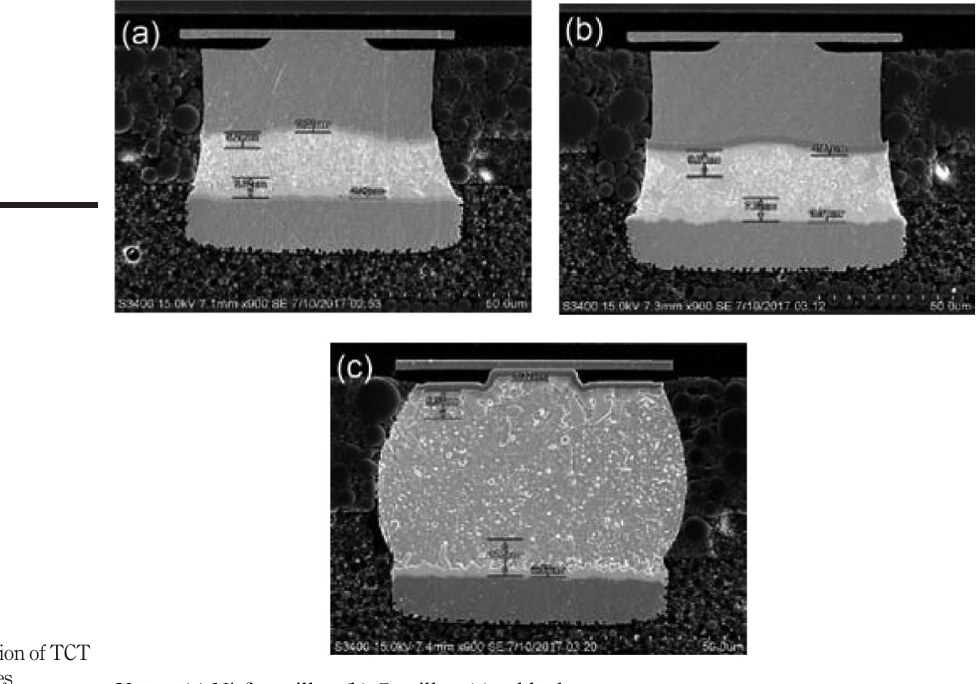
Figure 5. Cross-section of TCT